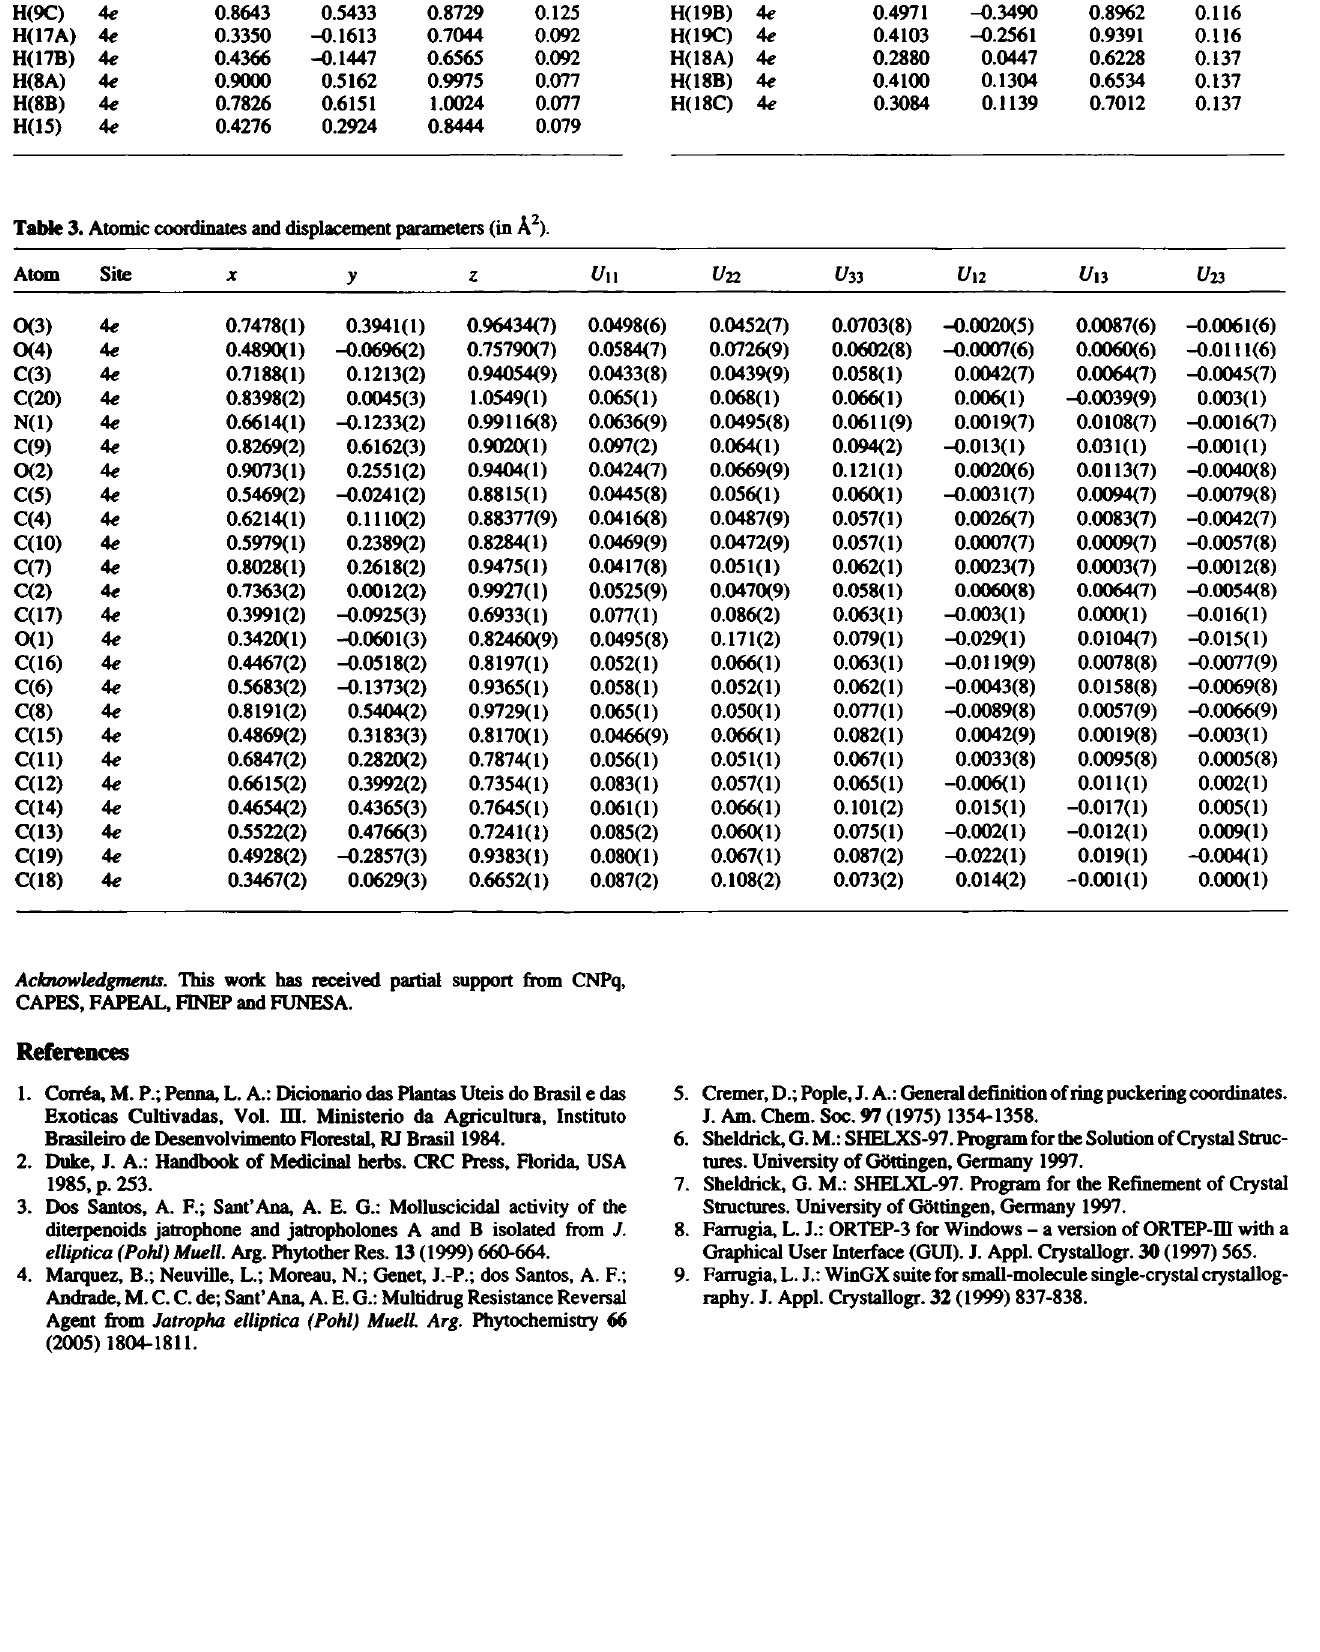
Table 3. Atomic coordinates and displacement parameters (in A 2